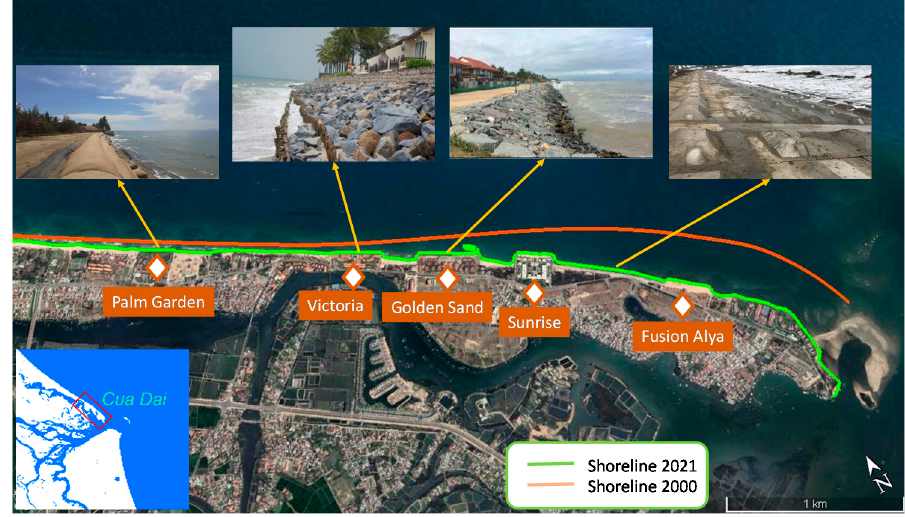
Figure 17. Construction of groins and seawall in front of resorts along the northern Cua Dai.